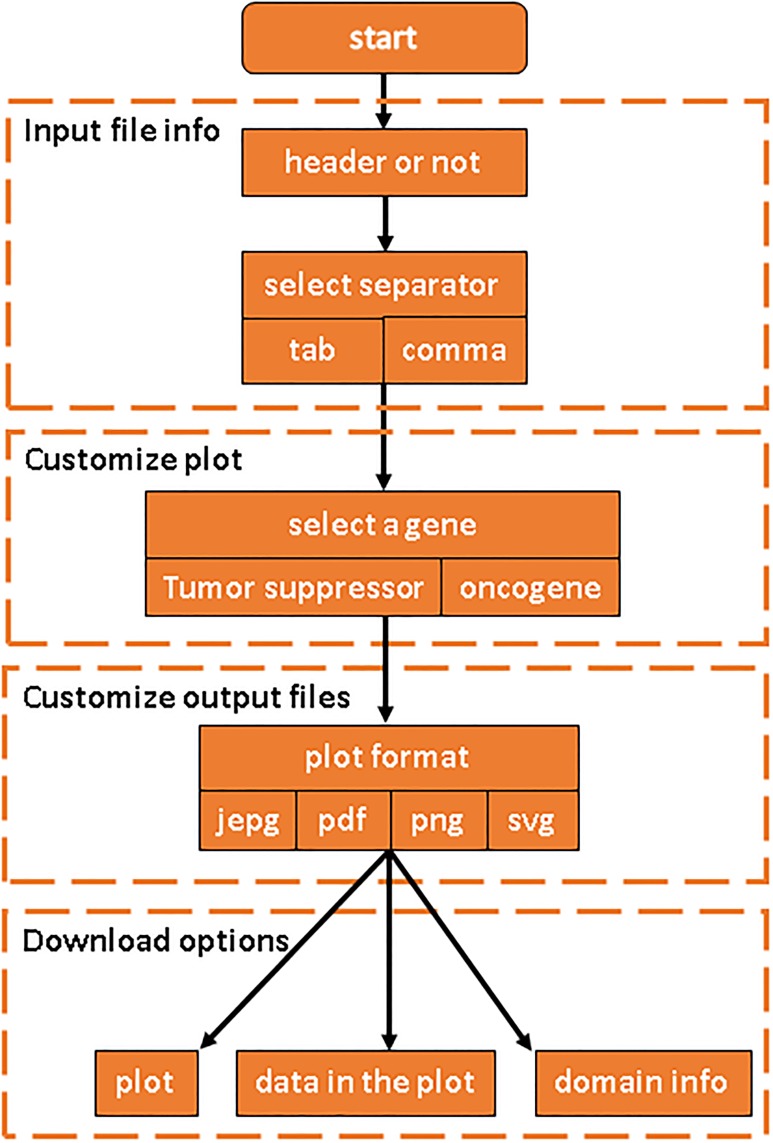
Mutplot workflow.